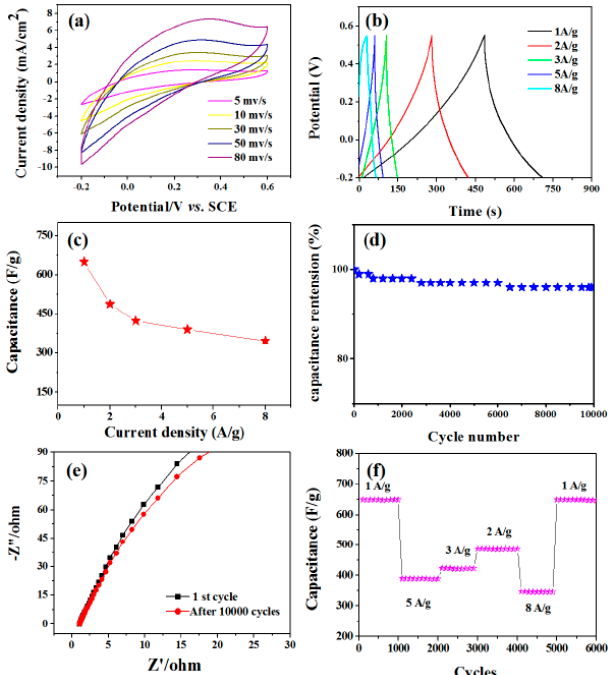
Figure 7. Electrochemical characterization of the MoO 3 nanorod film in a three electrode system. ( a ) CV curves of MoO 3 nanorods at a scan rate of 5, 10, 30, 50, and 80 mV/s. ( b ) Charge/discharge curves at current densities of 1, 2, 3, 5, and 8 A/g. ( c ) Current density dependence of the specific capacitance. The inset is the cycling property with the density of 3 A/g. ( d ) Cycling performance under the condition of different current densities. ( e ) The electrical conductivity of the product for the first and last 10,000 cycles of the Nyquist plots. ( f ) The cycling performance of the MoO 3 nanorods tested at different current densities.